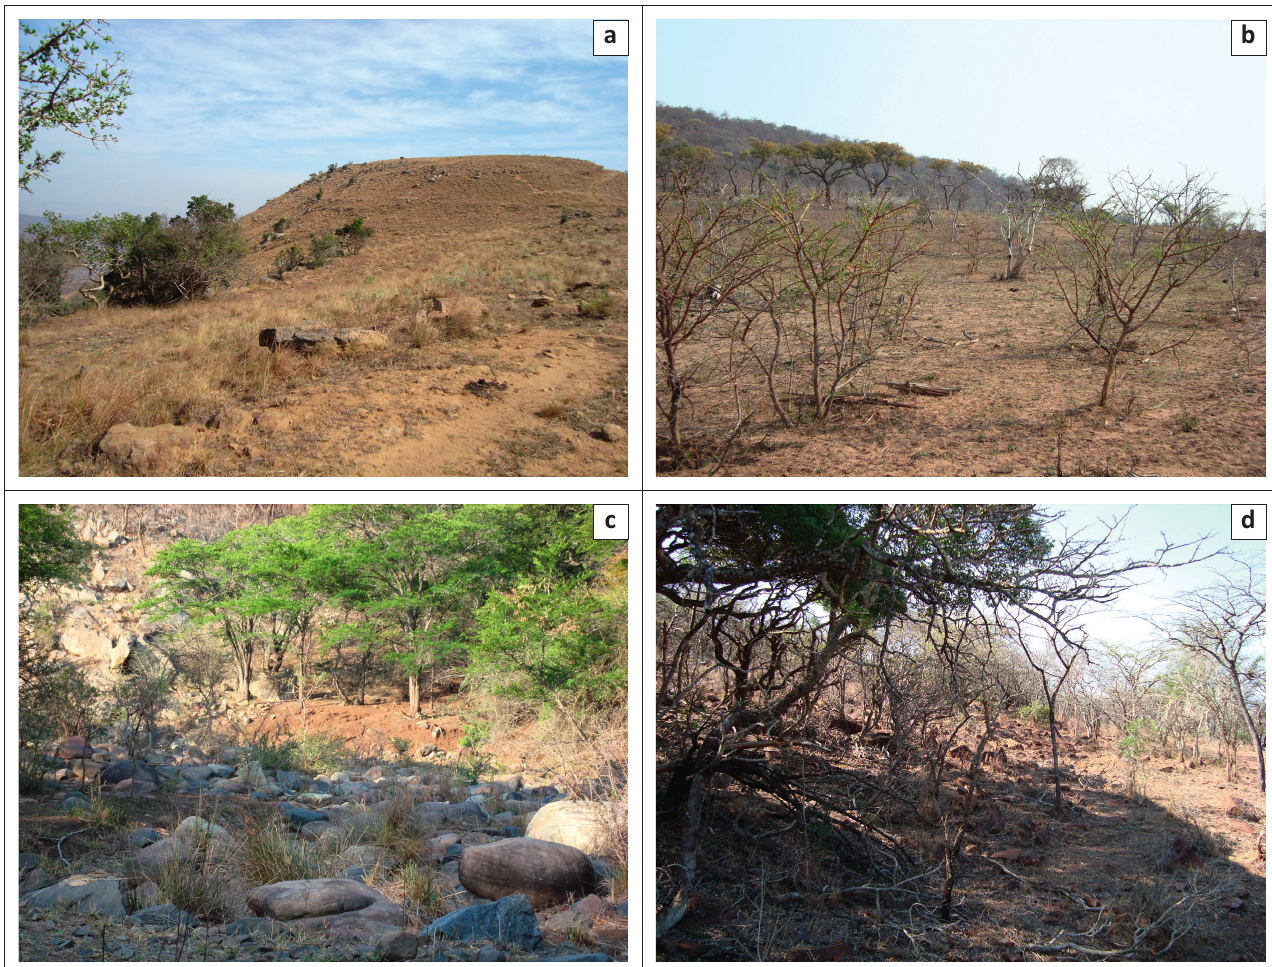
FIGURE 2: Habitats sampled in the Ophathe Game Reserve during October 2008 as part of the SANSA II field survey: (a) montane grassland; (b) overgrazed savanna; (c) Ombesanoni River bed and (d) rocky